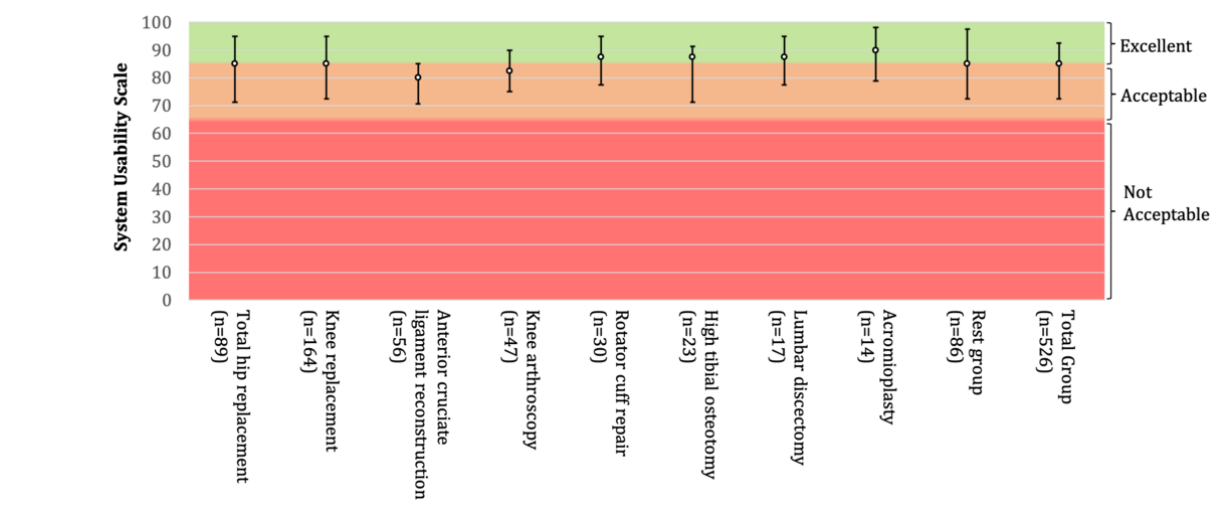
Figure 3. Usability.